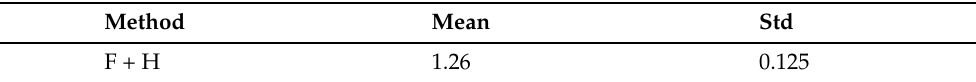
Table 3. Reconstruction accuracy of mesh on synthetic data using point-to-plane distance with fast two-stage filtering combined with hole restoration and depth optimization (F + H). The table reports the mean error (Mean) and the standard deviation